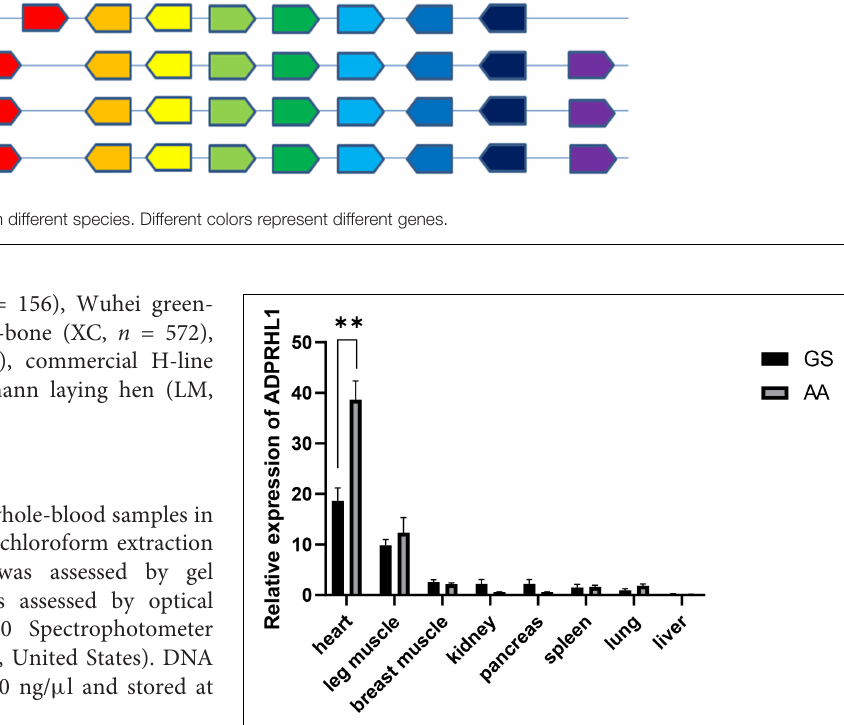
FIGURE 2 | Relative expression patterns of ADPRHL1 . Relative expression patterns of ADPRHL1 in GS chicken and AA broiler tissues at 1 week of age. GS, Gushi chicken; AA, Arbor Acres broilers. n = 8. ∗∗ P < 0.01.